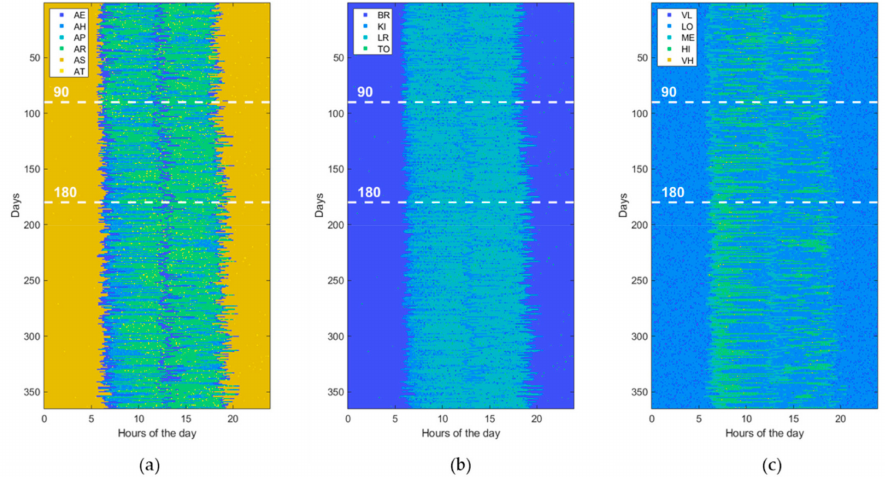
Figure 9. Example of an abnormal data set, due to a “Swap of two activities” (Sw). The change gradually takes place from the 90th day on. ( a ) ADL, ( b ) LOCs, and ( c ) HRLs.